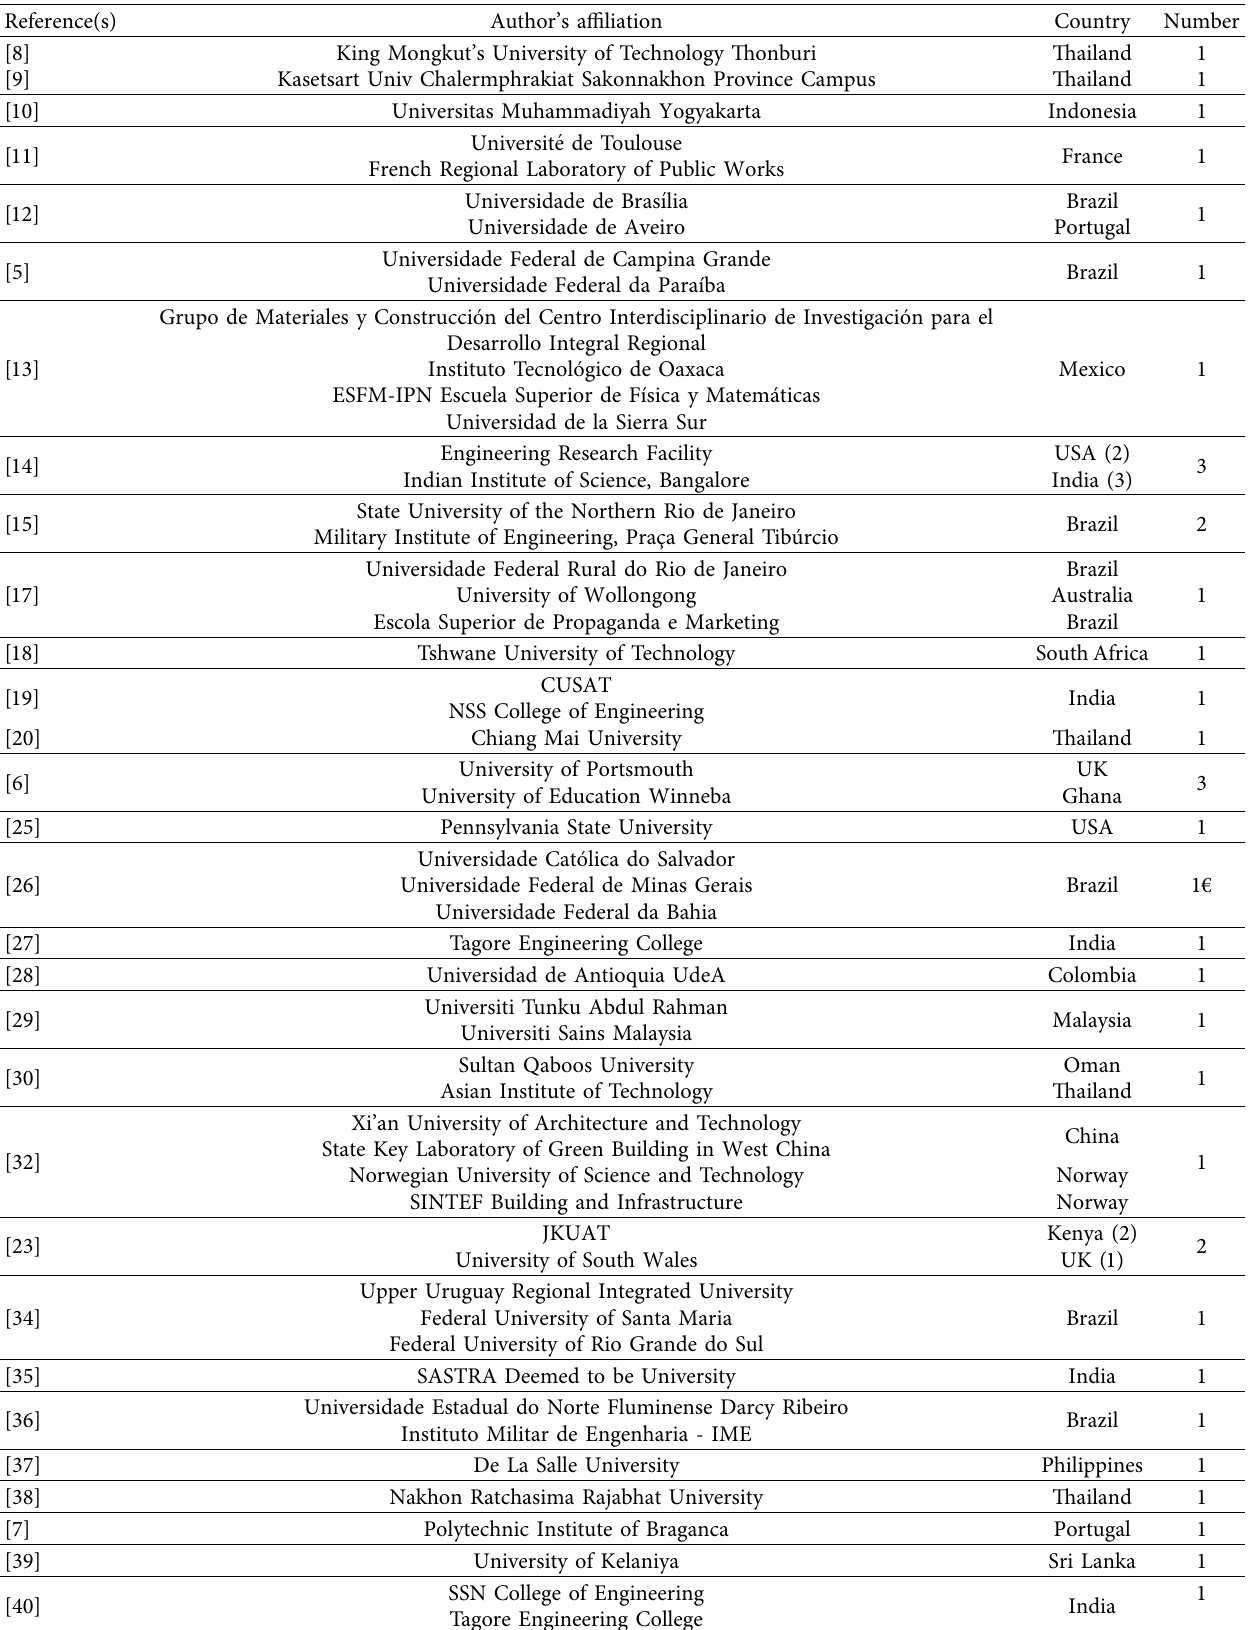
Table 2: Number of papers published ( n � 36) according to the author’s institute and country of affiliation.